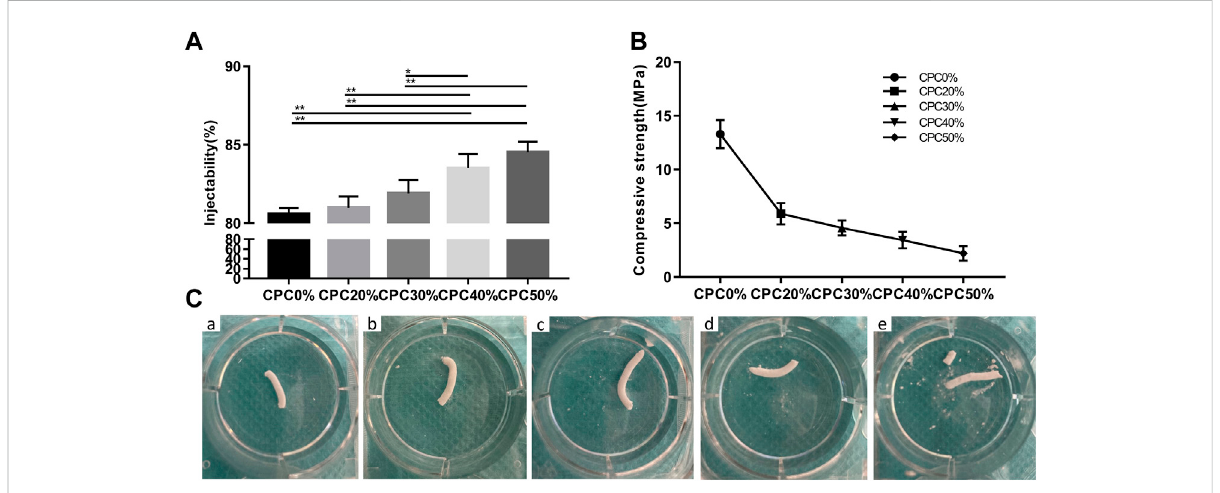
FIGURE 2 (A) Injectability of composite scaffolds with different microcapsule volume ratios. (B) Compressive strengths of composite scaffolds with different microcapsule volume ratios. (C) Images of composite scaffolds with different microcapsule volume ratios at 24 h after injection of